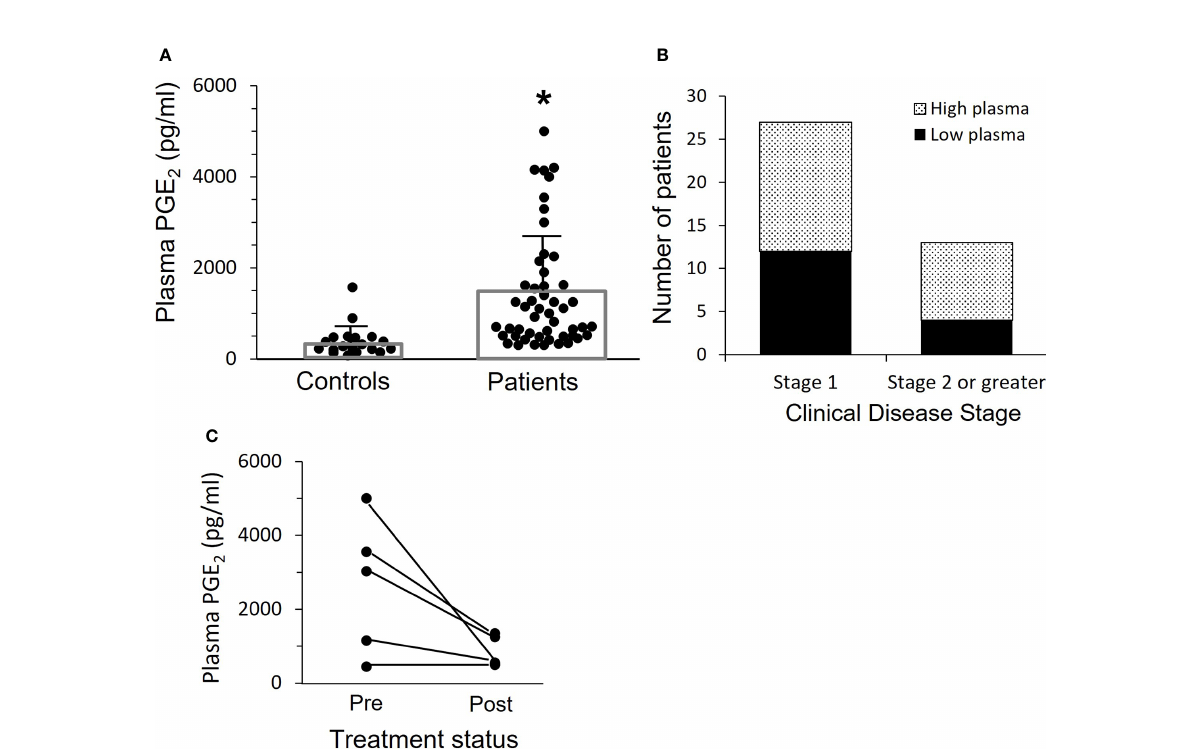
FIGURE 1 Patients with OPC have elevated levels of plasma PGE 2 . (A) PGE 2 levels in plasma were measured by ELISA. Bars indicate mean ± SD. Plasma levels are signi fi cantly increased in patients, 1409 ± 169 pg/mL, n=52, as compared to controls, 372 ± 63 pg/mL, n=24, (*p < 0.0001, two-tailed unpaired t-test). (B) The patients shown in “ A ” with more advanced cancer (Stage 2 or greater) are more likely to have high plasma PGE 2 levels, which we have set at 800 pg/ml. Results shown are not signi fi cant due to relatively small numbers, but clearly patients with more advanced disease are more likely to have higher plasma levels. (C) Plasma levels were measured a second time in fi ve patients who were free of disease at least 16 months after surgery and subsequent treatment. Levels dropped in those with elevated PGE 2 initially, and mean difference pre vs. post approached signi fi cance (p=0.06, paired